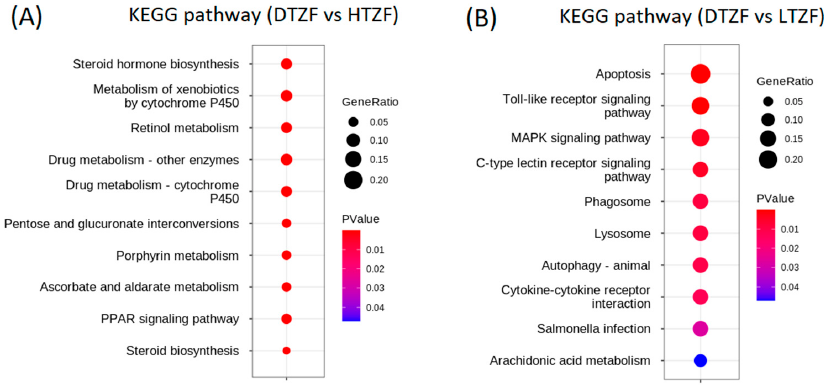
Figure 7. Top 10 KEGG pathways in the ( A ) HTZF (4.0 µ g/L thiram-treated ZF) and ( B ) LTZF (0.4 µ g/L thiram-treated ZF) compared with the DMZF group (dimethylsulfoxide-treated ZF). Table 3. List of significant DEGs for each enriched KEGG pathway in the HTZF group. Term Genes